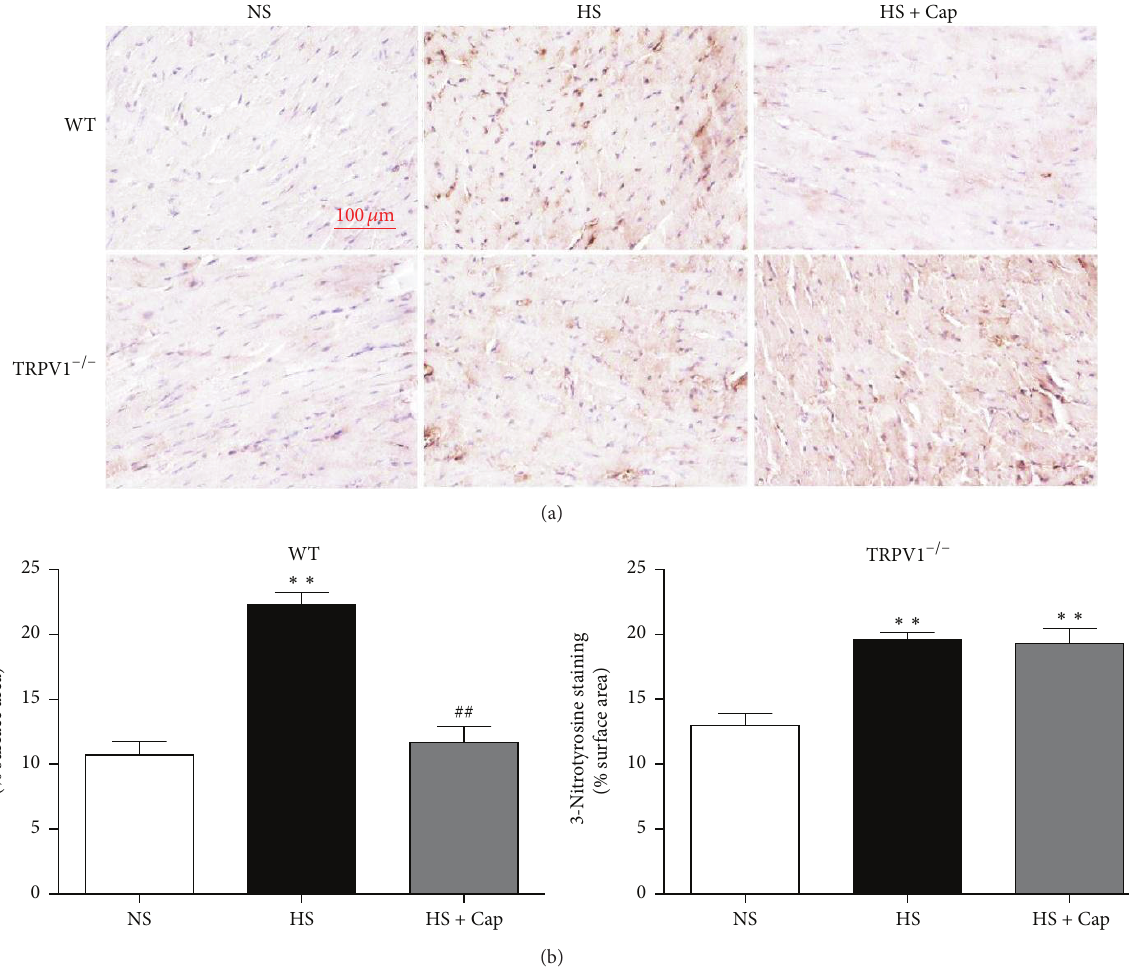
Figure 6: Activation of TRPV1 relieves oxidative/nitrotyrosine stress in mice on long-term high-salt diet. (a) Representative examples of LV sections from WT and TRPV1 −/− mice stained for 3-nitrotyrosine. (b) 3-Nitrotyrosine staining and scoring of expression in LV of various groups. Values were expressed as the mean ± SEM from 7 separate experiments. ∗∗ 𝑃 < 0.01 versus NS; ## 𝑃 < 0.01 versus